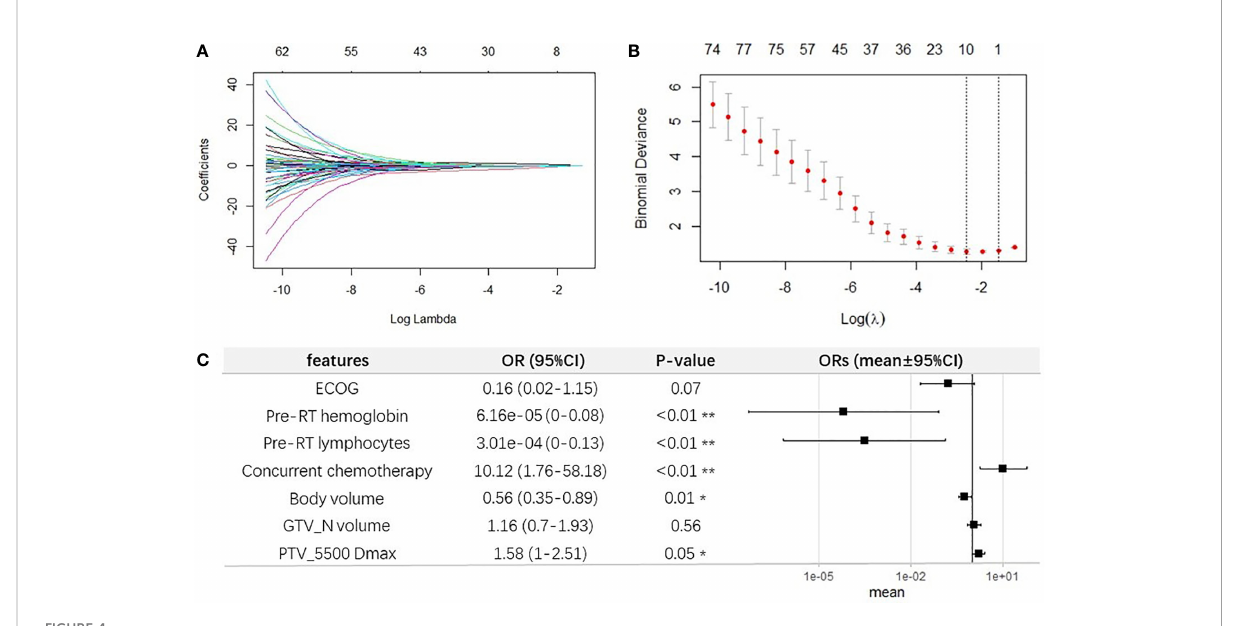
FIGURE 4 Elastic-net regression modeling for selecting important features for G4 ALC nadir. (A) Elastic-net coef fi cient pro fi les of all factors. (B) The selected optimal parameter (lambda) in the most moderate elastic-net model. (C) Forest plot of the seven selected important features for G4 ALC nadir.